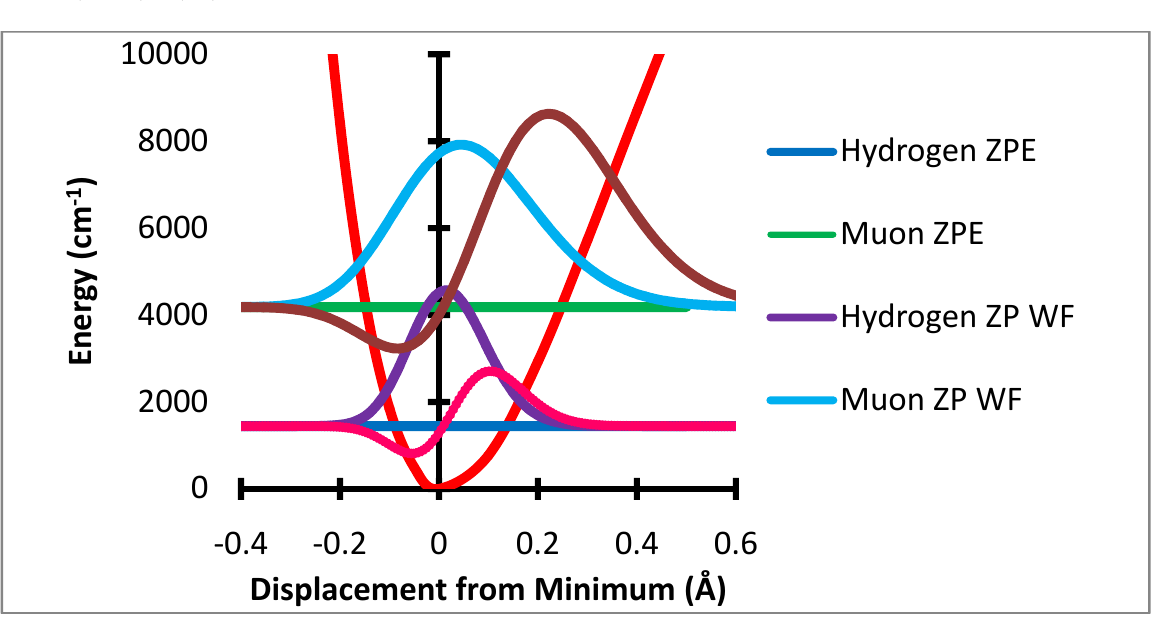
Figure 4. Stretching displacement potential (red curve) and probability distributions for H and Mu showing (dashed or dotted lines) the product of the probability times the variation of a(R-R )-a(R e e